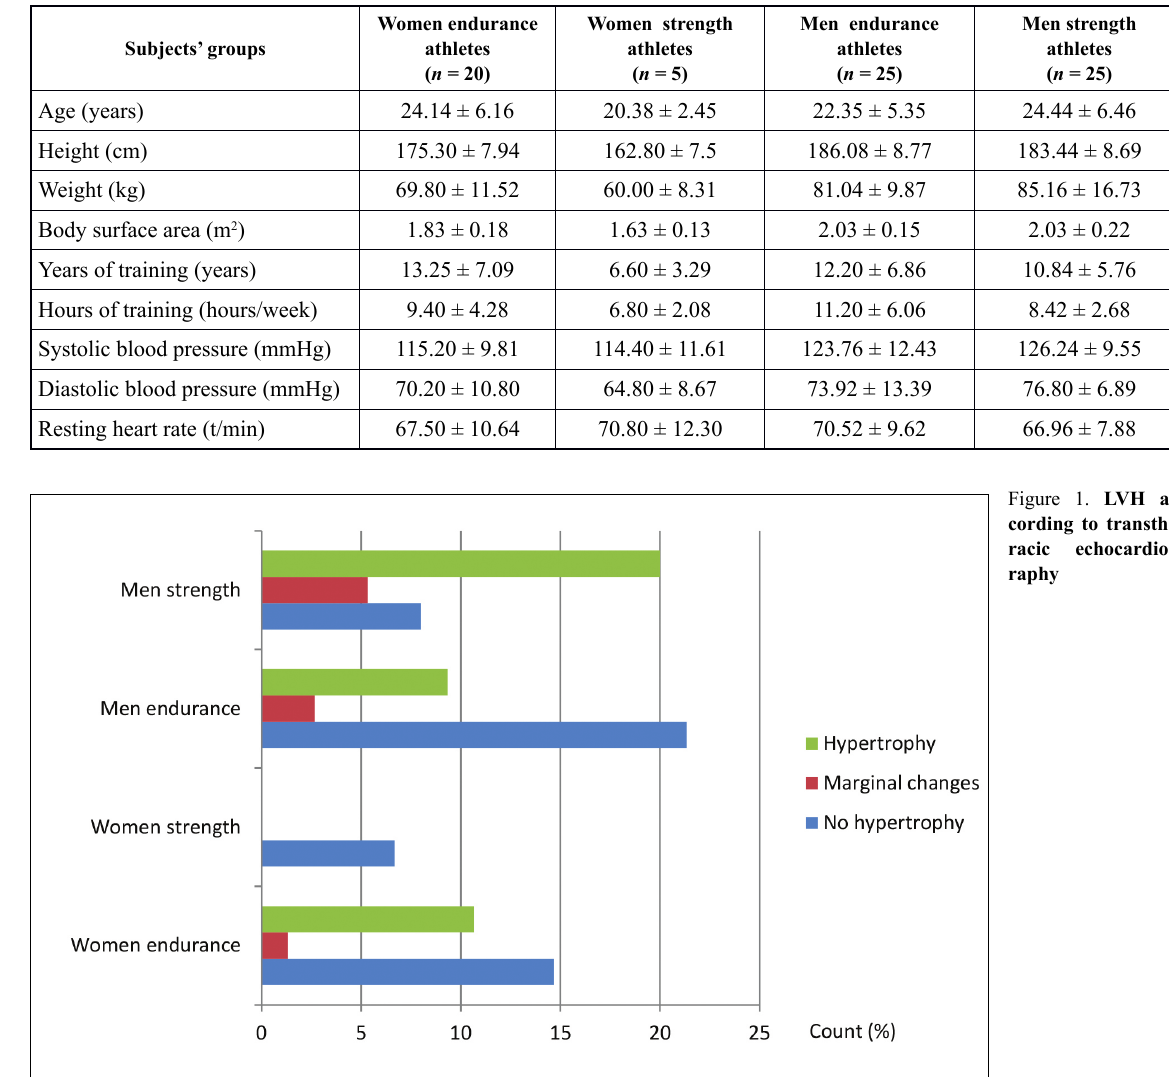
Table 1. Athletes’ characteristics by gender Subjects’ groups